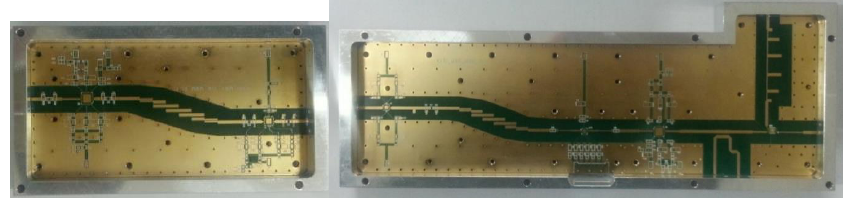
Figure 6. AMP (left) and RCV (right) modules.